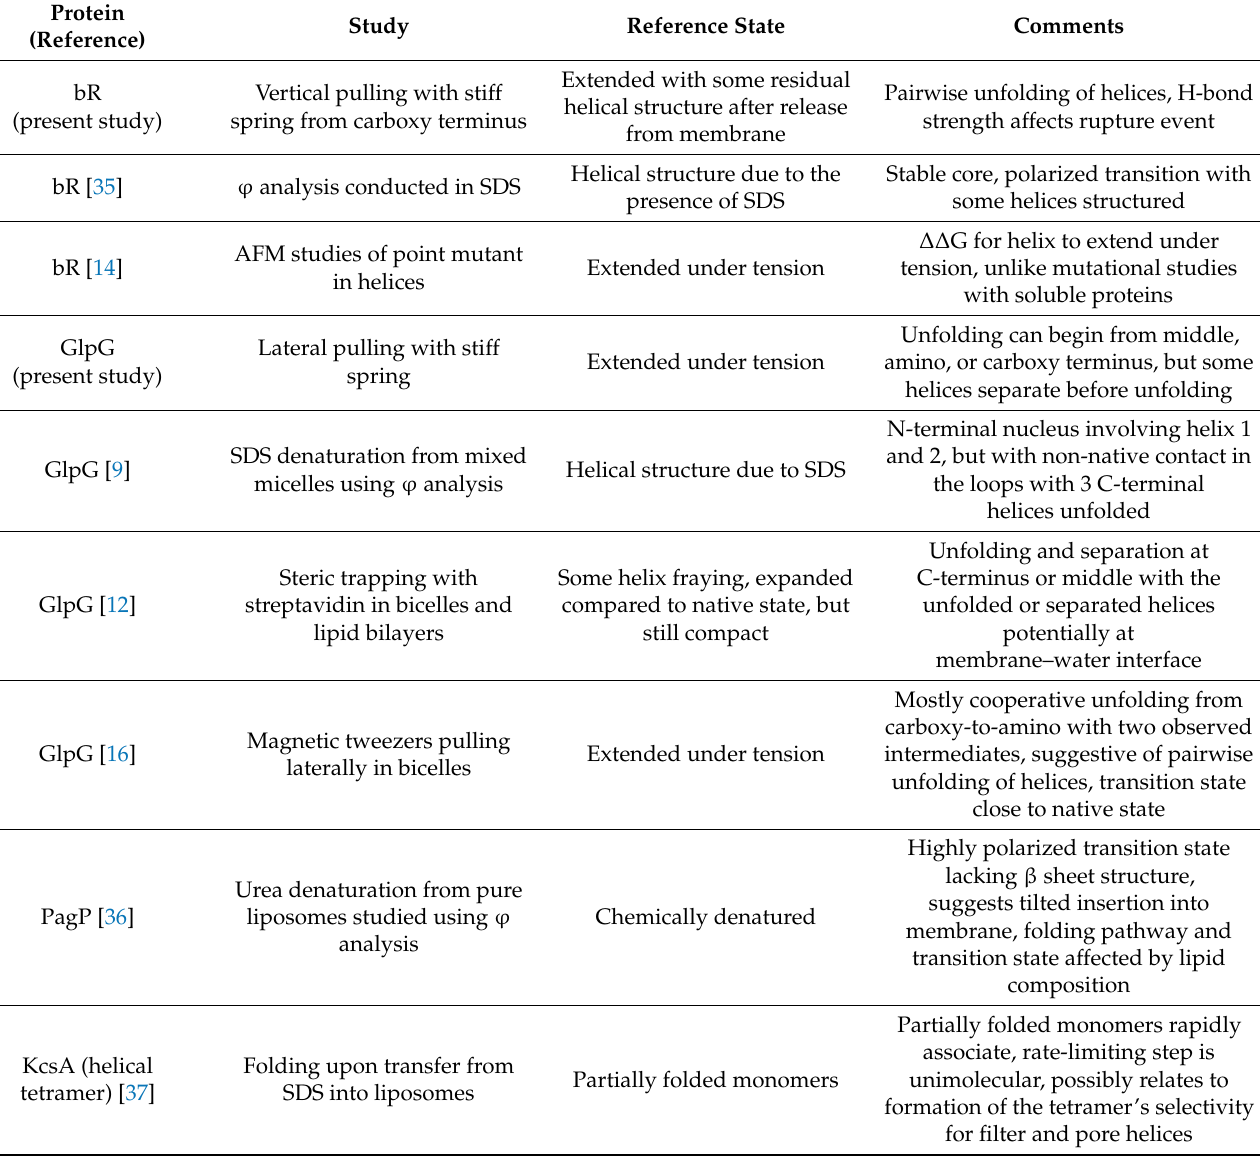
Table 3. Folding studies of bR, GlpG, and other membrane